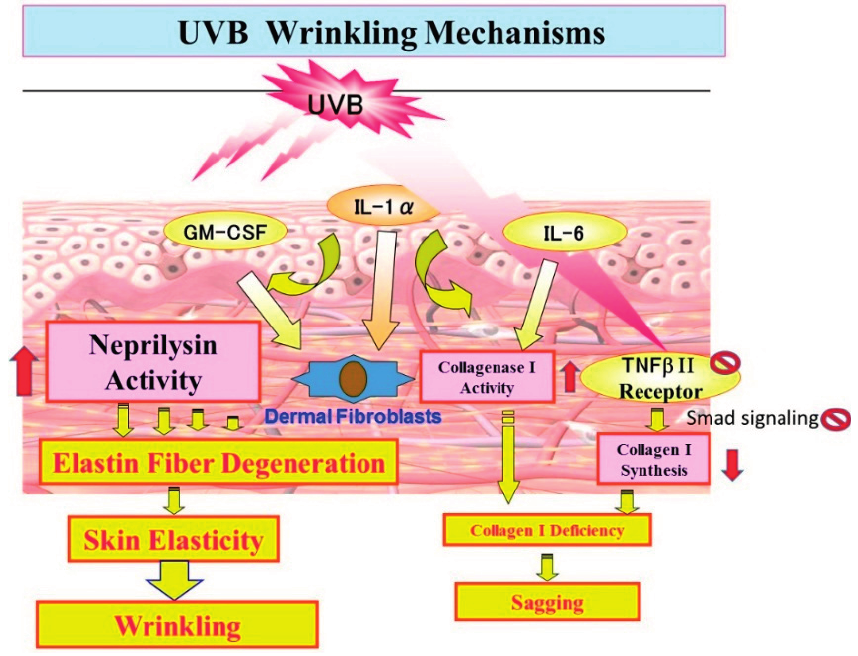
Figure 12. UVB wrinkling mechanisms.